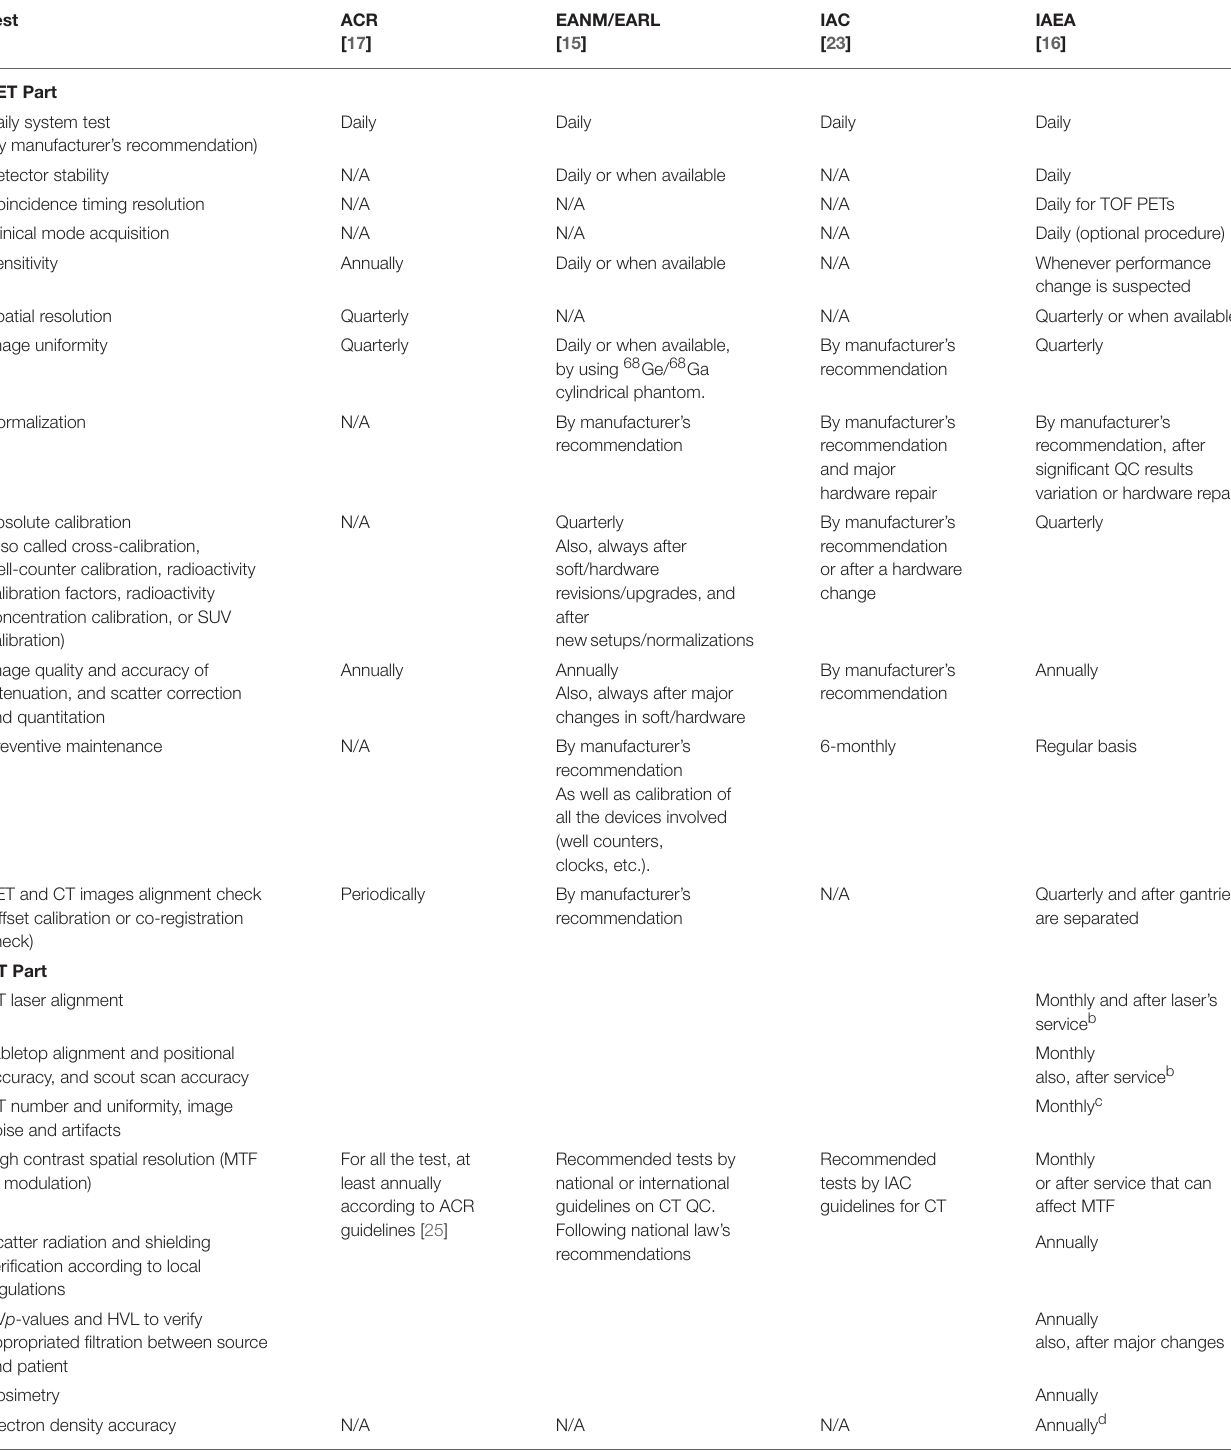
TABLE 1 | QC tests for PET and PET/CT